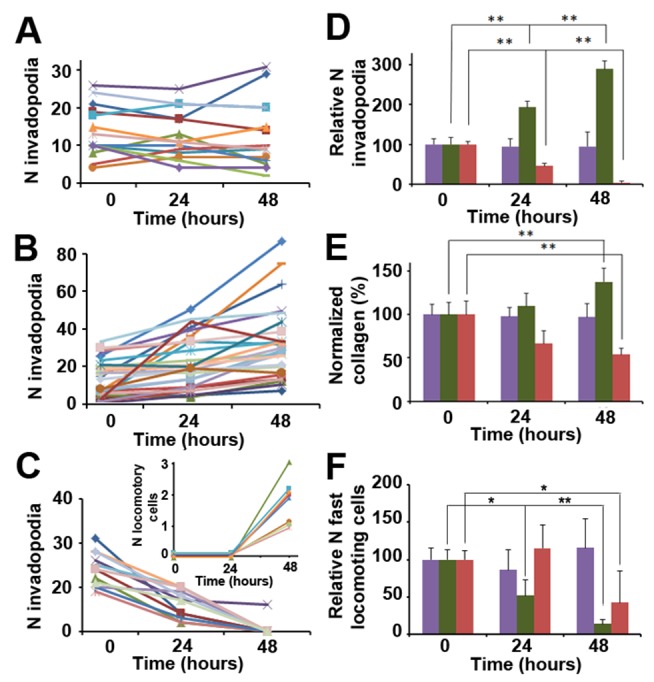
ECM modulation changes the frequency of motility phenotypes and may induce phenotype switching.(A–C) The number of invadopodia monitored in matched fields of view remains stable over 2 days. Each field of view is represented by different line color. (B) Invadopodium number is significantly increased by 1 g/kg/day L-ribose treatment. (C) Invadopodium number is diminished by 6 mg/kg/day BAPN treatment. Inset: some fields of view start exhibiting fast-locomotion phenotype when invadopodia are diminished. Such transition correlates with loosening of the ECM. (D) Quantification of raw data from (A–C). Normalized numbers of invadopodia show no significant change in control areas 0–48 h (purple bars). A significant increase follows L-ribose treatment (green bars, p<10−3) and a significant decrease follows BAPN treatment (red bars, p<10−4) based on paired t-tests. Average values along with ±SEM are shown. (E) Normalized collagen fiber density, measured by second harmonic in the same areas as (D), follows the same trends as invadopodia numbers. While control areas show minimal collagen remodeling over 48 h, treatment with L-ribose (green bars) increases cross-linking and fiber bundling, resulting in fiber density increase, while BAPN treatment (red bars) reduces cross-linking and results in lower fiber density at 48 h. Also See Figure S8. (F) Numbers of fast locomoting cells show no significant change in control areas 0–48 h (purple bars), while L-ribose treatment (green bars) induces significant reduction of fast locomotion. In addition, BAPN treatment (red bars) induces reduction of fast locomotion at 48 h. Average values along with ±SEM are shown, paired t-tests were done for comparison, *p<0.05, **p<0.01.